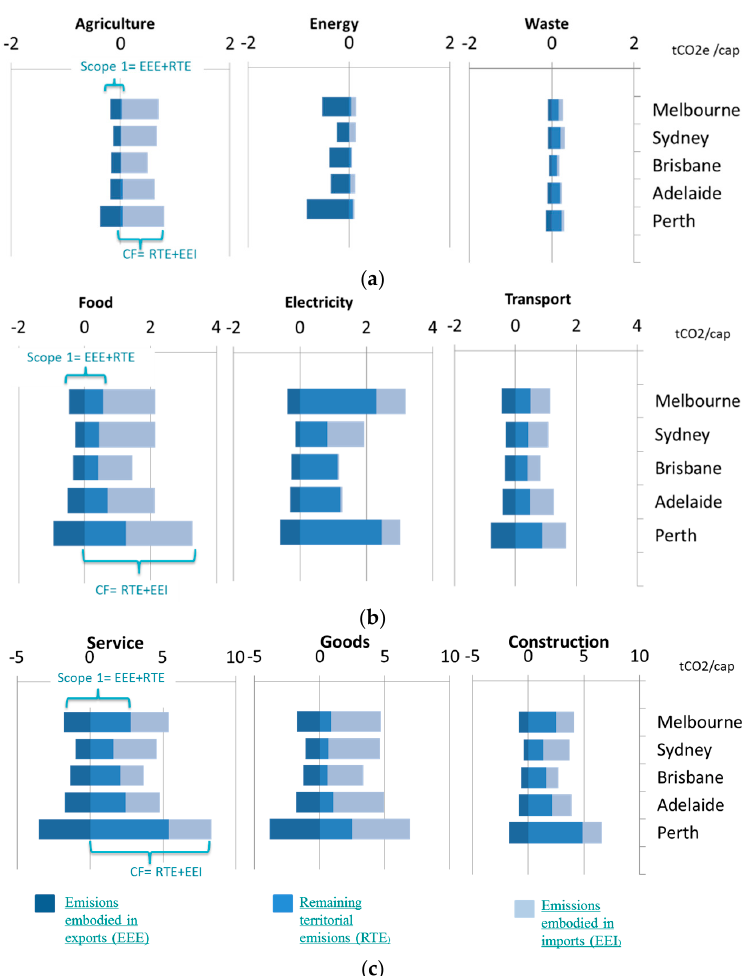
Figure 2. Per ‐ capita sectoral GHG emissions of five Australian cities (t CO 2 e/cap): ( a ) includes Agriculture, Energy and Wate sectors; ( b ) includes Food, Electricity and Transport sectors; and ( c ) includes Service, Goods and Construction sectors. Please note the different scales in each of the